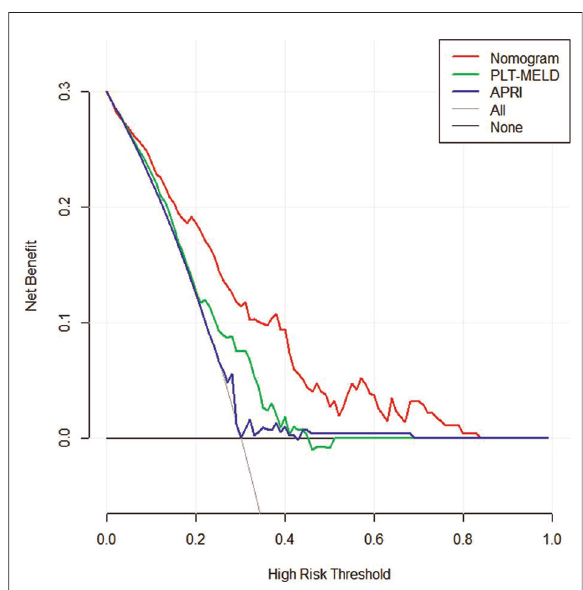
FIGURE 5 Decision curves for prediction of the net bene fi t of the constructed nomogram, PLT-MELD and APRI. Gray line: net bene fi t of a strategy of treating all patients with esophagogastric varices in hepatitis B cirrhosis. Horizontal black line: net bene fi t of treating no patients with esophagogastric varices in hepatitis B cirrhosis. Colored lines: net bene fi t of a strategy of treating patients according to nomogram, PLT-MELD and APRI. Red line: screen based on the nomogram; green line: screen based on the PLT-MELD; blue line: screen based on the